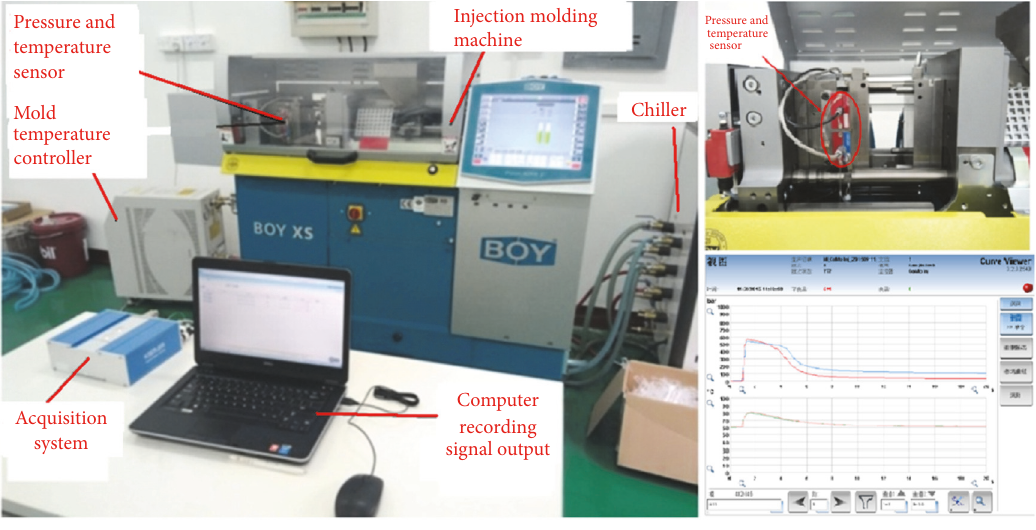
Figure 1: Experimental setup.